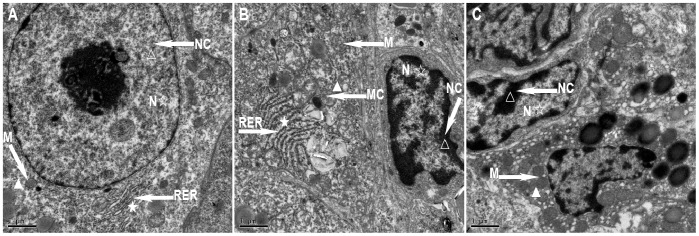
The ultrastructural changes of the rats’ ovarian tissues in the control, PCOS, and PCOS EA groups.The ultrastructural changes of the rats’ ovarian tissues were observed by transmission electron microscopy, as described in the Materials and Methods section. A) A representative rat’s ovarian tissue section from the control group, which had normal appearance (A×10000). B) A representative rat’s ovarian tissue section from the PCOS group, which showed a reduced number of organelles, condensation and margination of the nuclear chromatin, mitochondrial swelling, broken or even disappeared mitochondrial cristae, and expanded endoplasmic reticulum (B×10000). C) A representative rat’s ovarian tissue section from the PCOS EA group, which showed increased mitochondria in granular cells, many cristae (with some destroyed) in part of the mitochondria, condensation and margination of nuclear chromatin (C×10000). M: mitochondria, N: nucleus, RER: rough endoplasmic reticulum, NC: nuclear chromatin, MC: mitochondrial cristae. ☆ indicated the changes of nucleus, ★ indicated the changes of rough endoplasmic reticulum, △: indicated the changes of nuclear chromatin, ▴ indicated the changes of mitochondria and mitochondrial cristae. Scale bar, 1 µm.